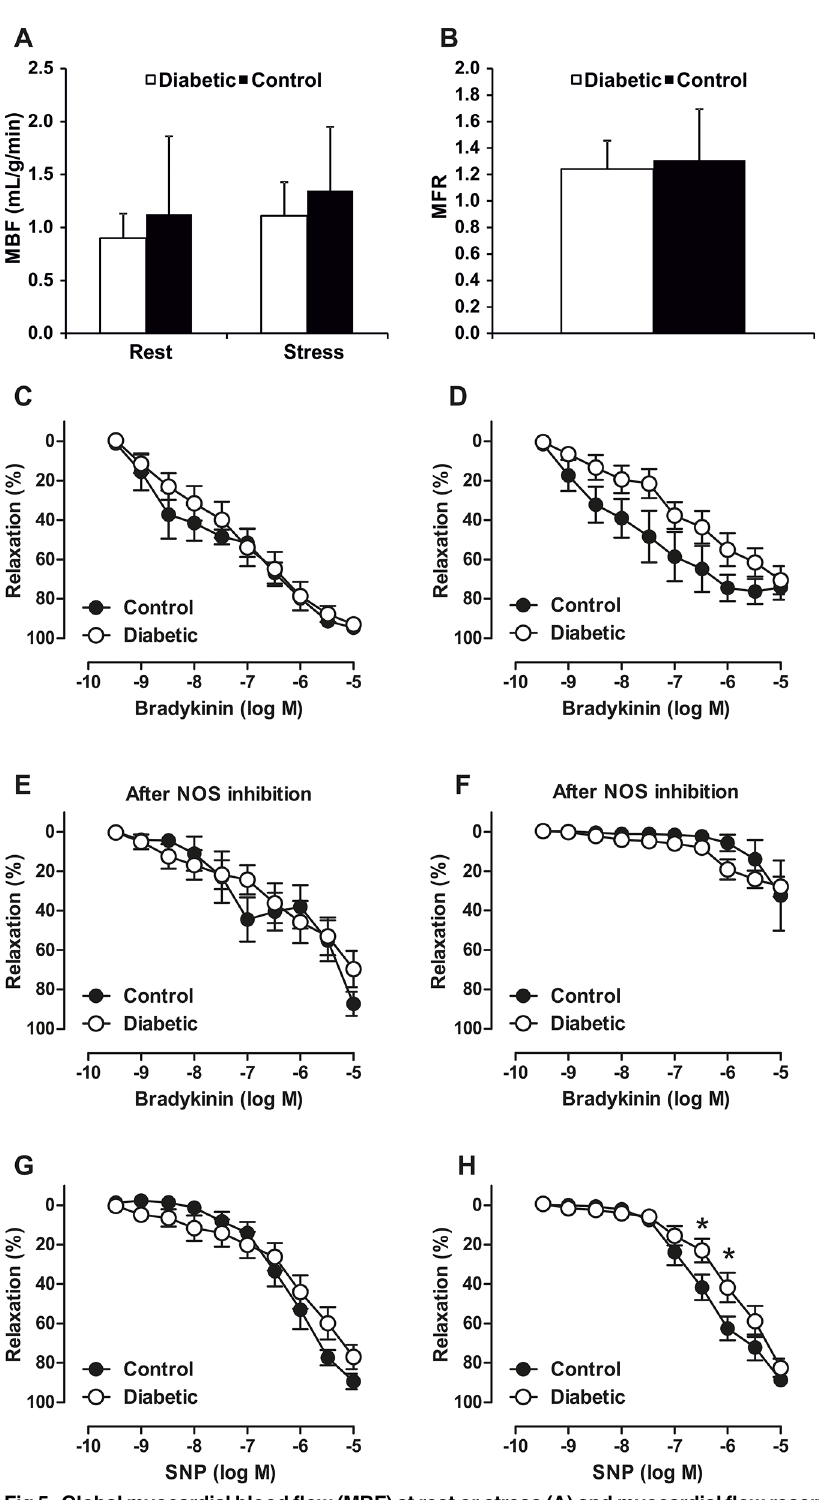
Fig 5. Global myocardial blood flow (MBF) at rest or stress (A) and myocardial flow reserve (MFR) (B) were comparable in diabetic (open bars) and control (black bars) animals. Wire-myograph results of distal parts of the left anterior descending artery showing different relaxation responses to bradykinin and sodium nitroprusside (SNP) of atherosclerotic and healthy animal and between small ~150 μ m (C, E, G)